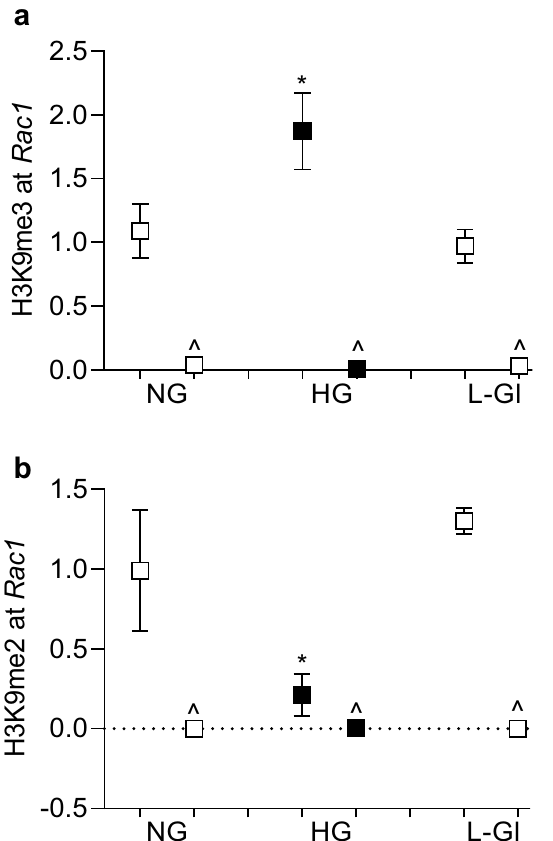
Figure 1. Effect of high glucose on H3K9 methylation. HRECs incubated in 5 mM (NG) or 20 mM (HG) D-glucose, or 20 mM L-glucose (L-Gl), for 96 h were analyzed for ( a ) H3K9me3 and ( b ) H3K9me2 at Rac1 promoter by ChIP technique using normal rabbit IgG (^) as an antibody control. Each measurement was made in duplicate 3–4 different cell preparation, and the values are represented as mean ± SD. * p < 0.05 vs